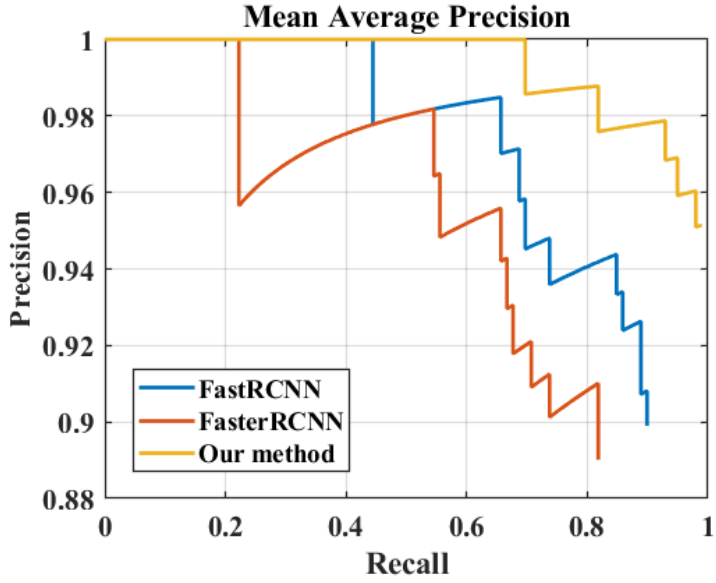
Figure 10. P-R curves of the three networks.